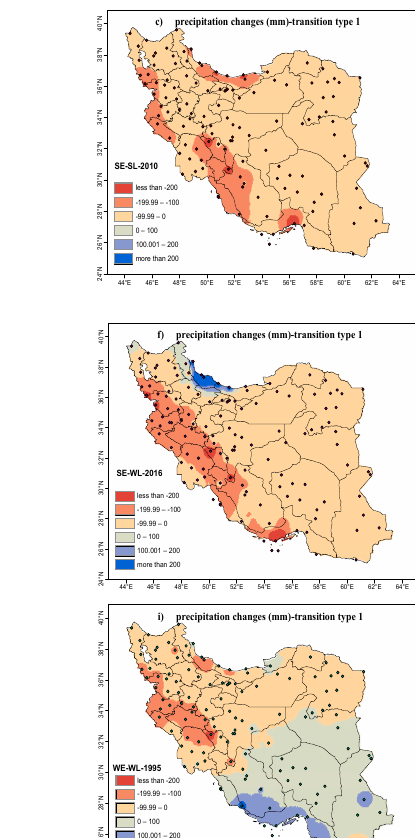
− 20.01 Table 3. Autumn precipitation values for all cases of ENSO transition type 2 years. Subtype